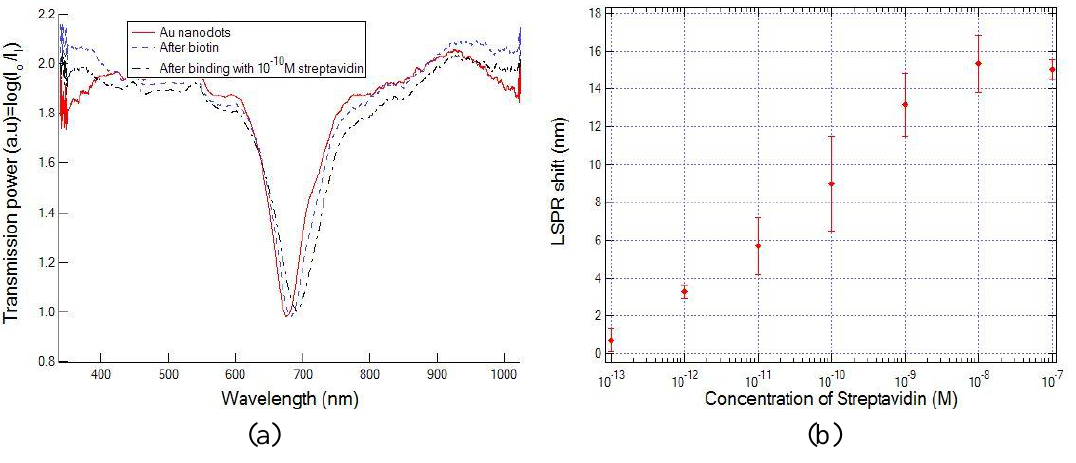
Figure 6. (a) Transmission spectrum and (b) plasmon peak shift due to the specific binding of streptavidin to the biotin on the Au nanodot surface on the optical fiber end facet. The error bars represent the standard deviation calculated from three independent